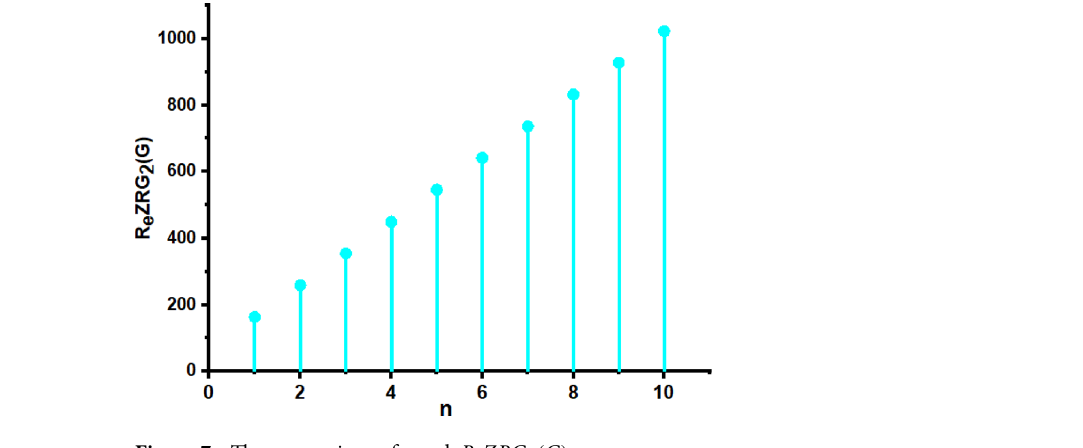
Figure 7. The comparison of n and . R e ZRG 2 ( G )